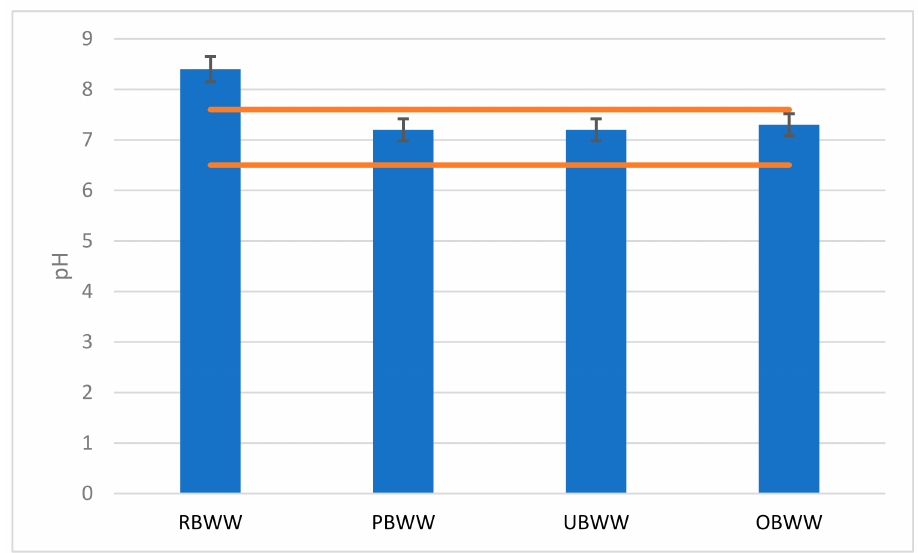
Figure 3. Change of backwash water pH during the treatment process: raw backwash water (RBWW), pre-filter backwash water (PBWW), ultrafiltration backwash water (UBWW), ozonation backwash water